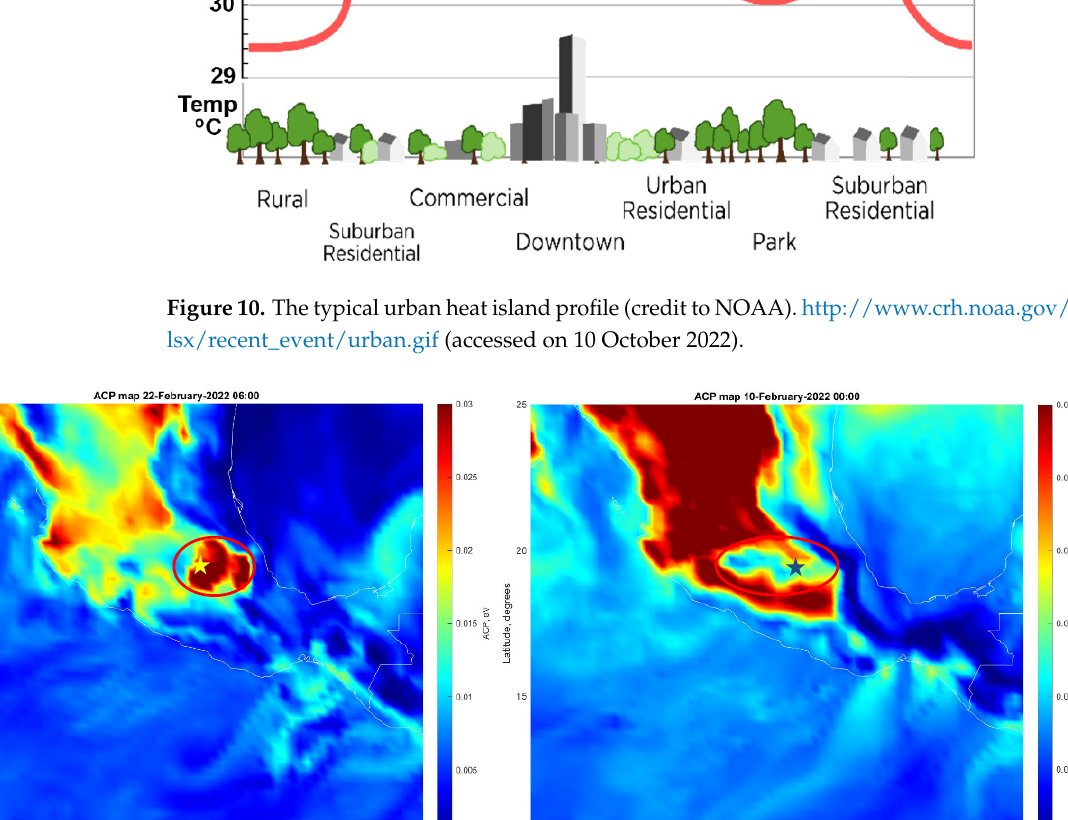
Figure 11. Left panel—the ACP distribution over Mexico at 06:00 UTC on 22 February 2022; right panel—the ACP distribution over Mexico at 00:00 UTC on 10 February 2022. The location of Mexico City is marked by asterisks. The areas of the suspected anomalies are encircled by red ovals.